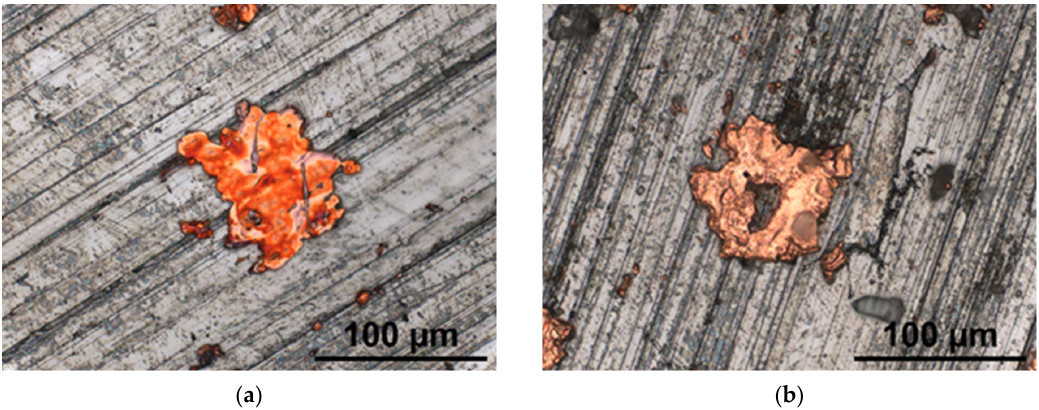
Figure 8. Reflected light microscopy images of wire arc copper splats formed upon impact on S235JR samples: ( a ) conventional spraying in air and ( b ) spraying in silane ‐ doped nitrogen.